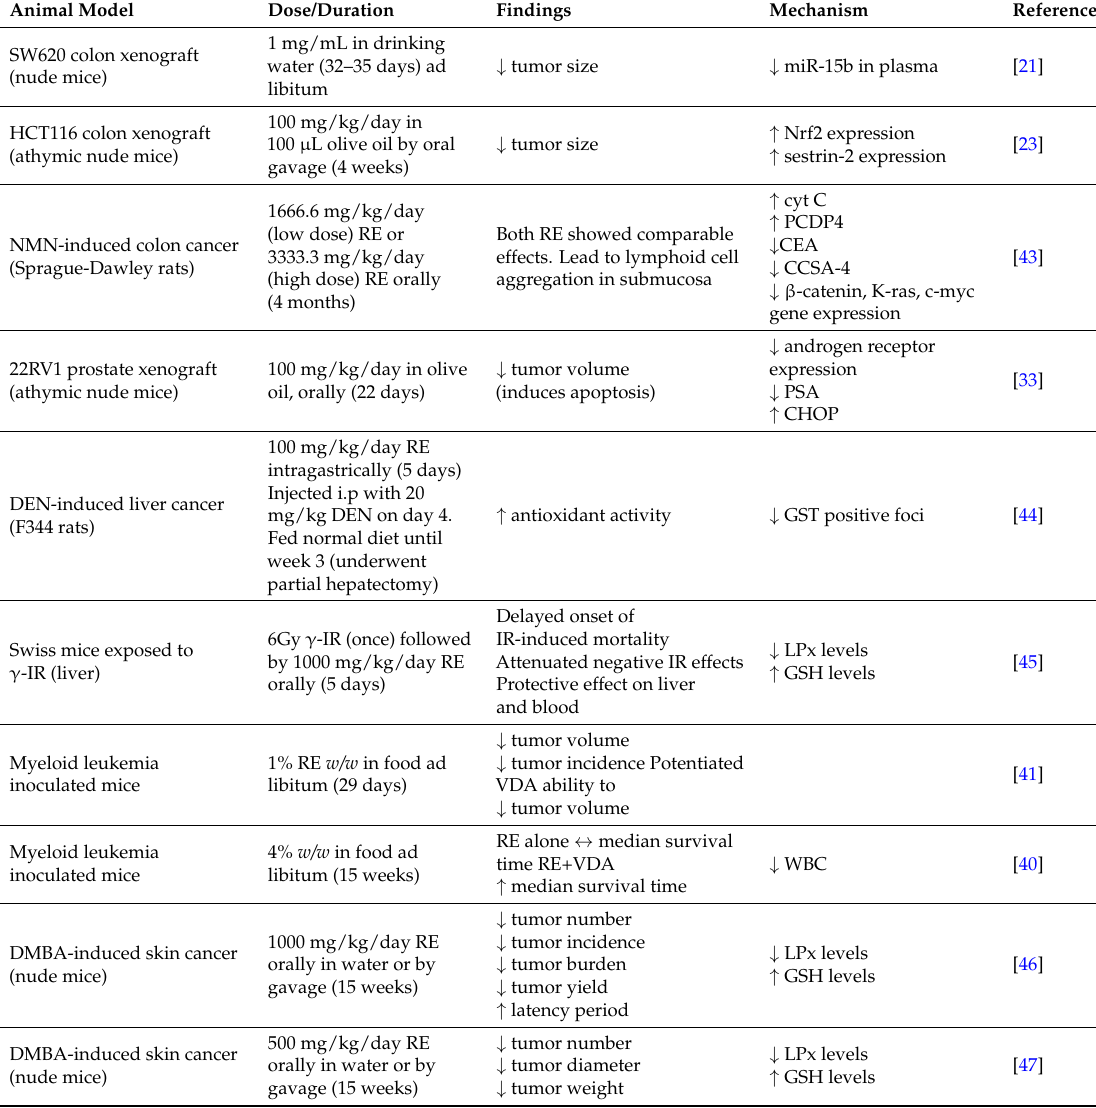
Table 6. Anticancer effects of Rosemary Extract (RE). In vivo